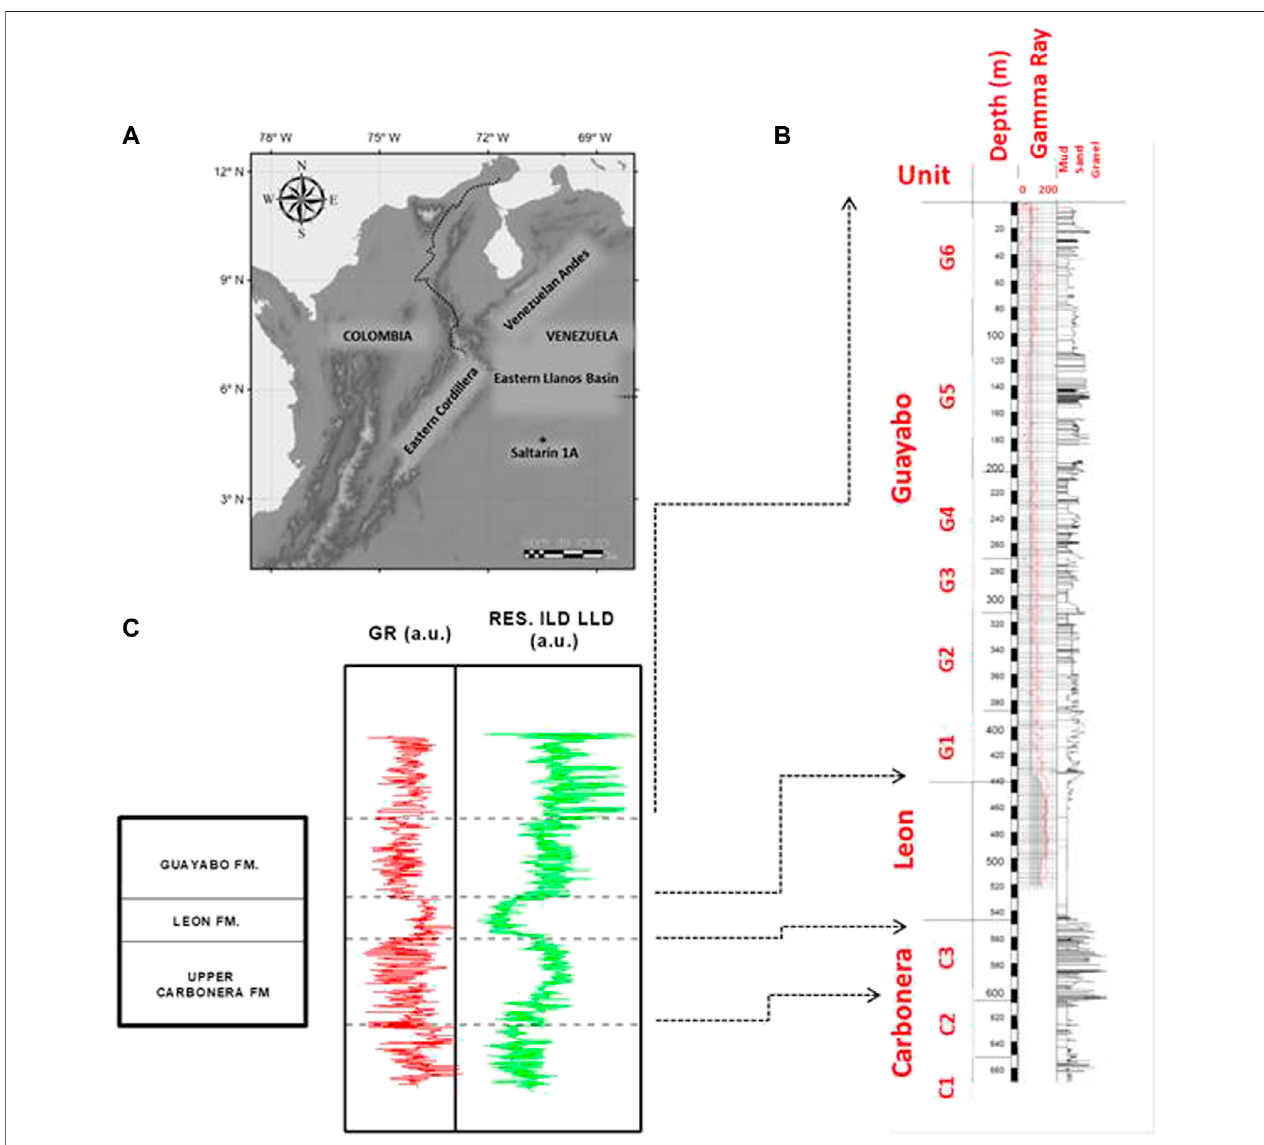
FIGURE2 | (A) Geographicalsetting ofthe stratigraphic well Saltarín 1A in the Colombian Eastern Llanos Basin(after Camacho et al., 2013). (B) Lithologic column ofthestratigraphicwellSaltarín1Ashowingthelimits,textures,andsedimentarystructuresforUpperCarbonera,Leon,andGuayaboFormationsandthecorresponding Gamma Ray (GR) log for the fi rst 520 m (after Costanzo-Álvarez et al., 2012). (C) Gamma Ray and Resistivity type-logs for the Eastern Llanos Basin showing the approximate boundaries of the Upper Carbonera, Leon and Guayabo Formations (Petroleum system chart for the Eastern Llanos Basin by Barrero et al., 2007). Arrows correlate the formational boundaries of the resistivity type-log with their corresponding equivalents fully identi fi ed in the Saltarin 1A (Bayona et al., 2008).